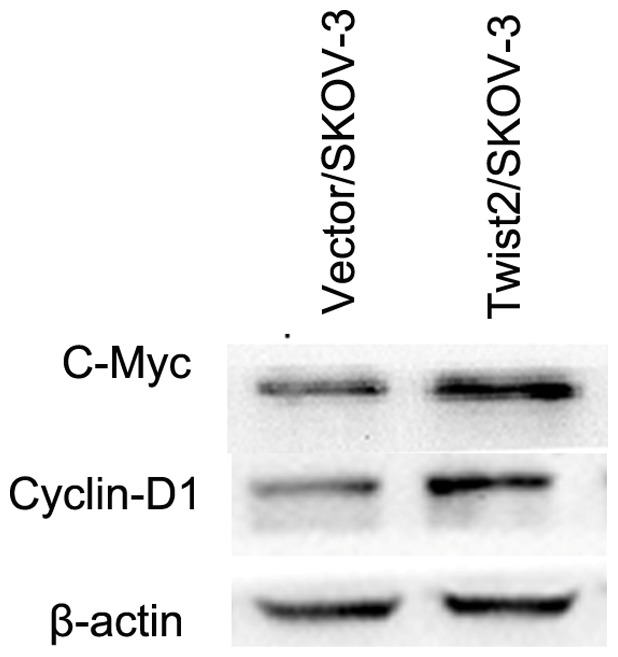
Downstream target proteins such as c-Myc, Cyclin-D1 in the Wnt signal pathway.As c-Myc and Cyclin-D1 are mostly regarded as Wnt target genes, we further examined their expressions by western blot repeated for three times. Immunoblot analysis showing that Both c-Myc and cyclin-D1 increased at the Twist2/SKOV-3 group compared with the Vector/SKOV-3 group in the representative figure.